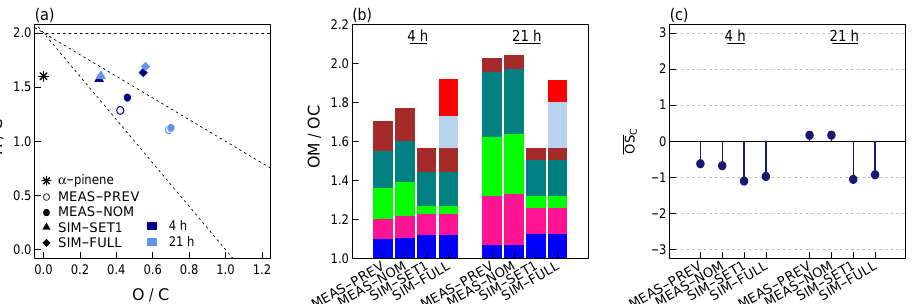
Figure 10. Comparison of measurement (MEAS) and simulations (SIM) for samples ending approximately at 4 and 21h (time-integrated over 3.1 to 4.2 and 17.6 and 21.6h, respectively) after initiation of photochemistry (Sax et al., 2005; Ruggeri et al., 2016). Further details on labels for estimates are defined in Sect. 3.4. Colors for (b) are the same as for Fig. 6, except that ketone and aldehyde has been combined into a single color (teal) because the reported measurements do not differentiate between the two types of